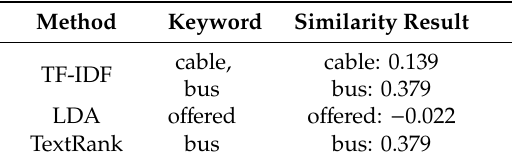
Table 4. Results of three types of keyword extraction